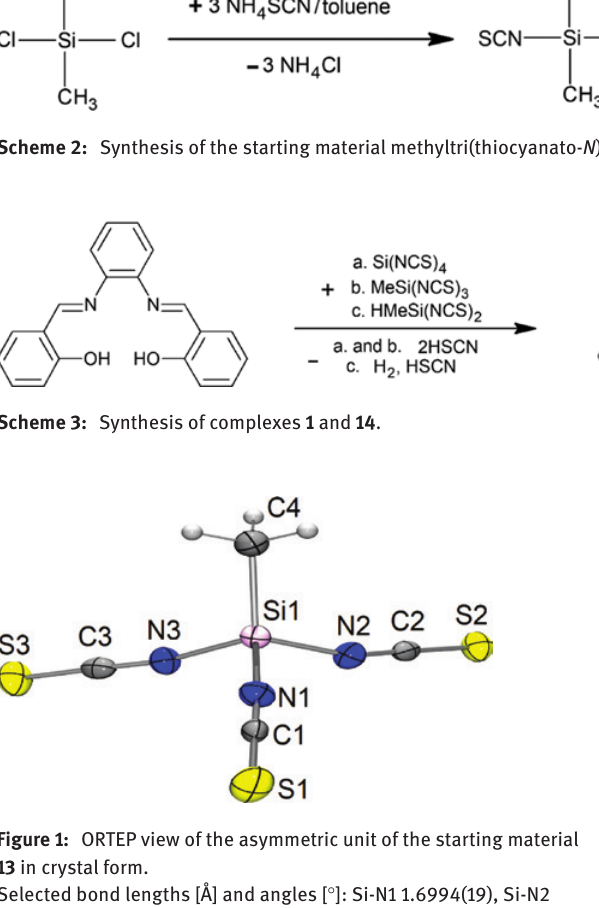
Figure 2: ORTEP view of the asymmetric unit of complex 1 in crystal form showing weak C-H · · · O intermolecular